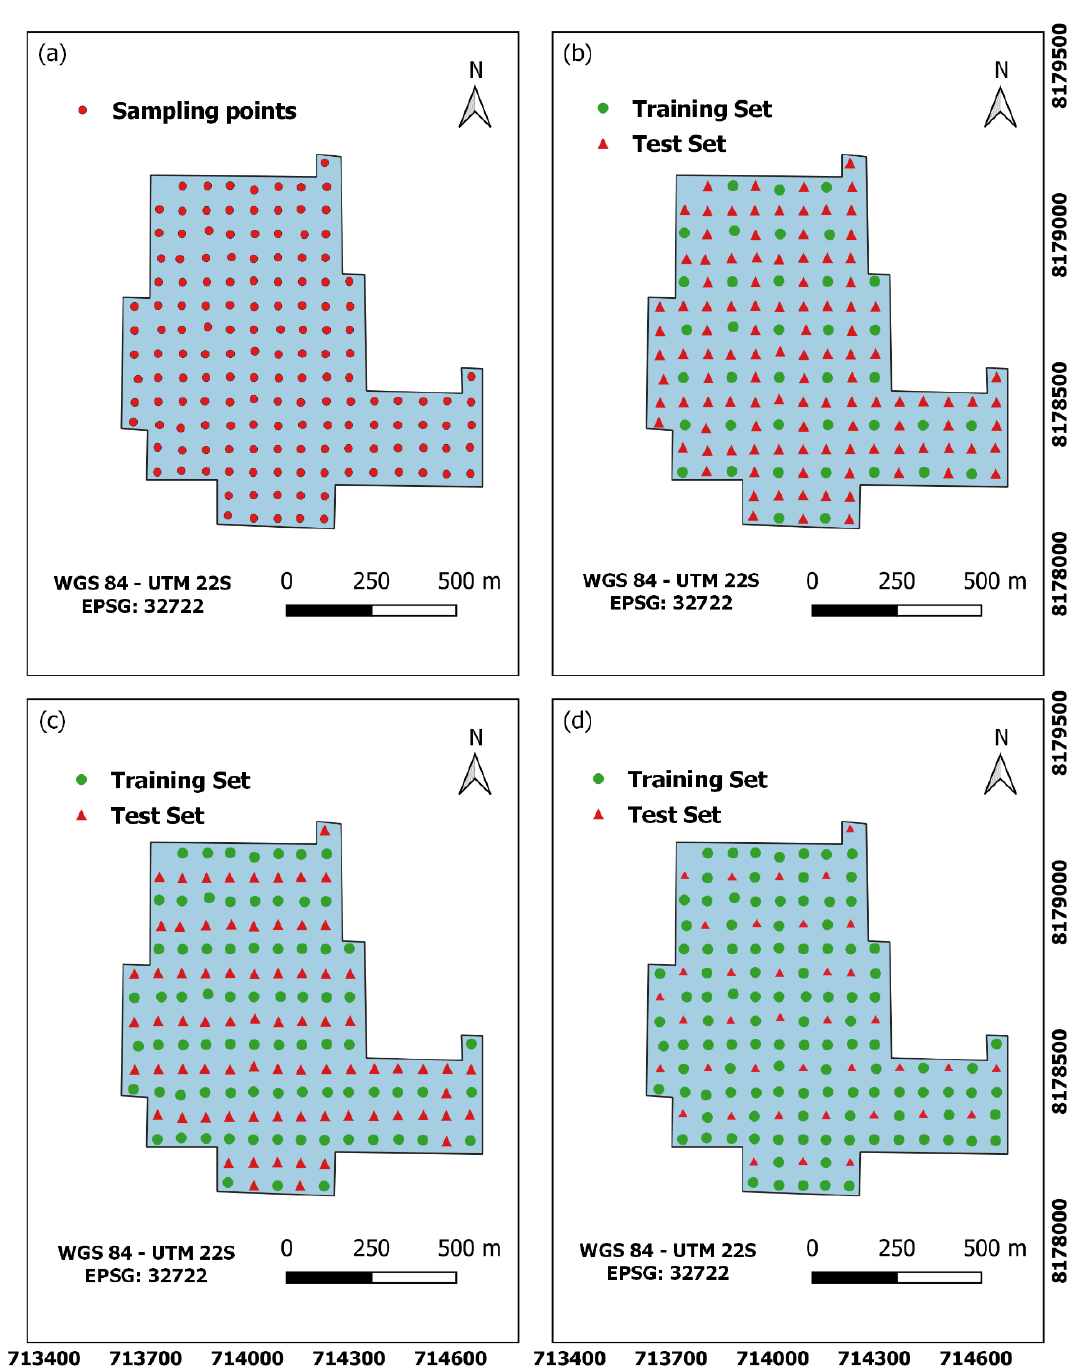
Figure 4. Number of sampling points in: ( a ) original grid with 150 points; ( b ) 38 points for training and 112 points for testing; ( c ) 75 points for training and 75 points for testing; ( d ) 112 points for training and 38 points for testing.